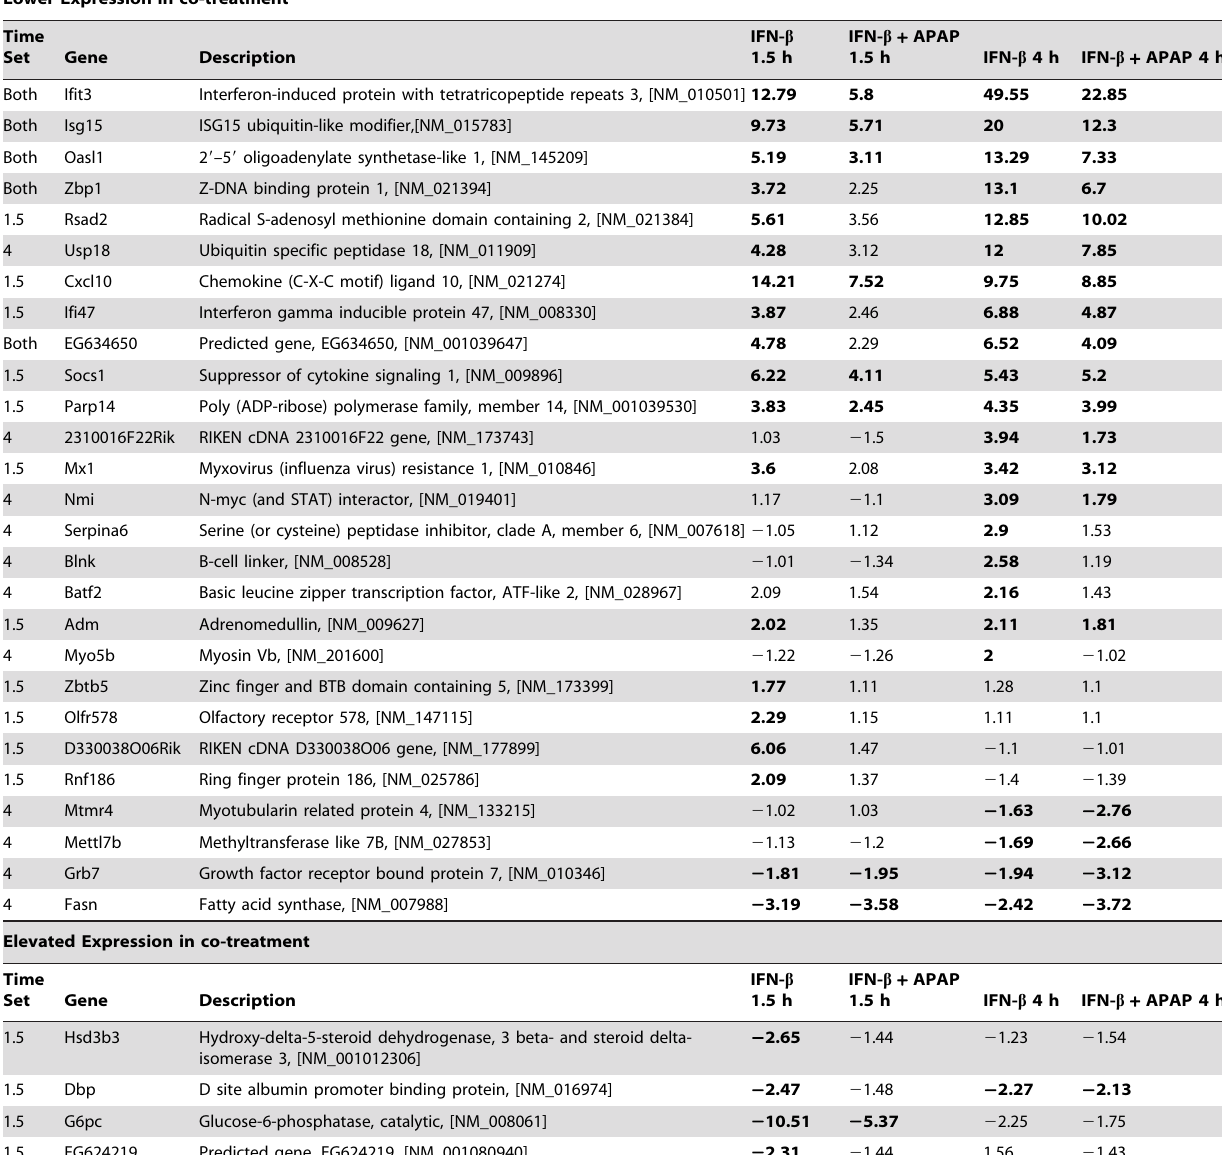
Table 2. List of genes altered by IFN- b with a 1.5 fold difference in co-treatment.